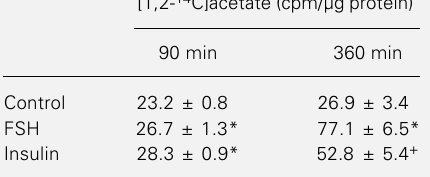
Table 2 - Effect of FSH and insulin on [1,2- 14 C] acetate incorporation into Sertoli cell lipids. Sertoli cells were pretreated for 16 h with 100 ng/ ml FSH or 5 (cid:181)g/ml insulin and incubated for 90